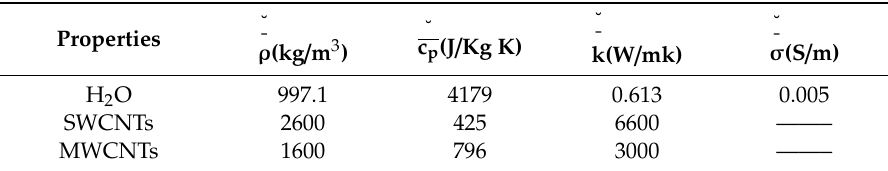
Table 1. Thermophysical characteristics of CNTs and H 2